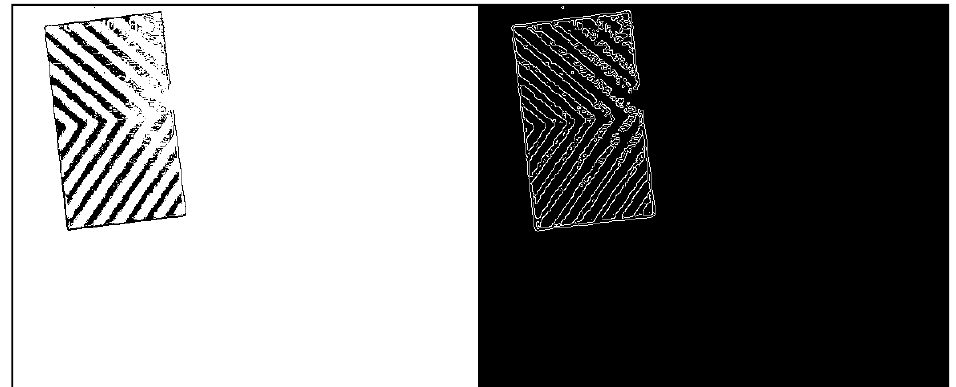
Figure 9. Pixel coordinate extraction process of hazard source mask layer.